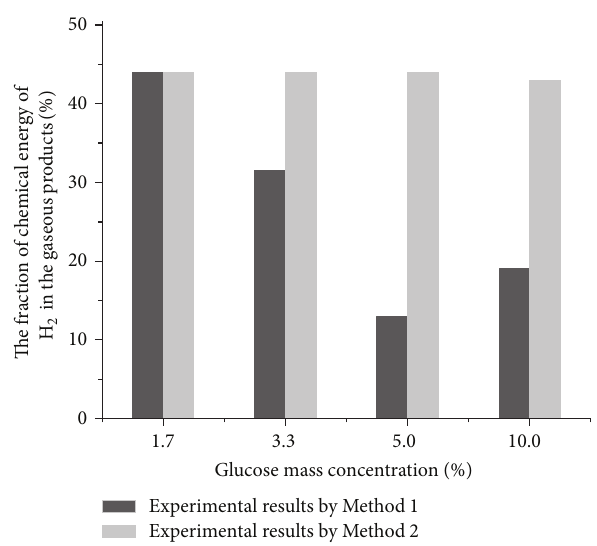
Figure 6: The variation of chemical exergy fraction of H 2 with the glucose concentration in the gaseous